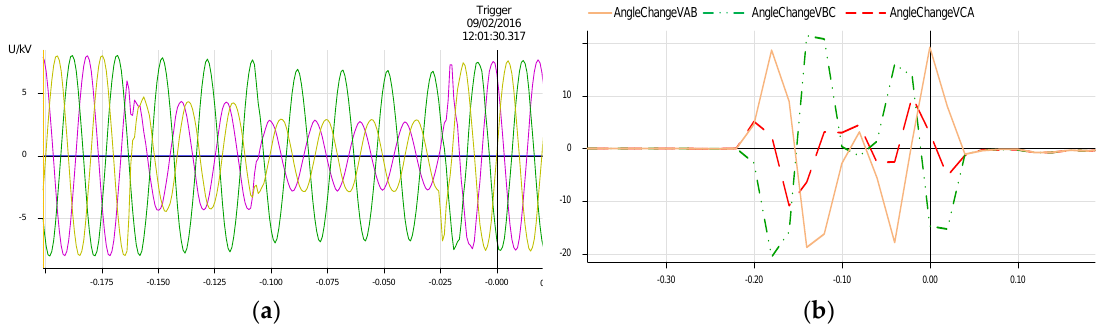
Figure 12. ( a ) Waveform recorder from AC phase to phase fault; ( b ) phase to phase voltage angle change during fault.